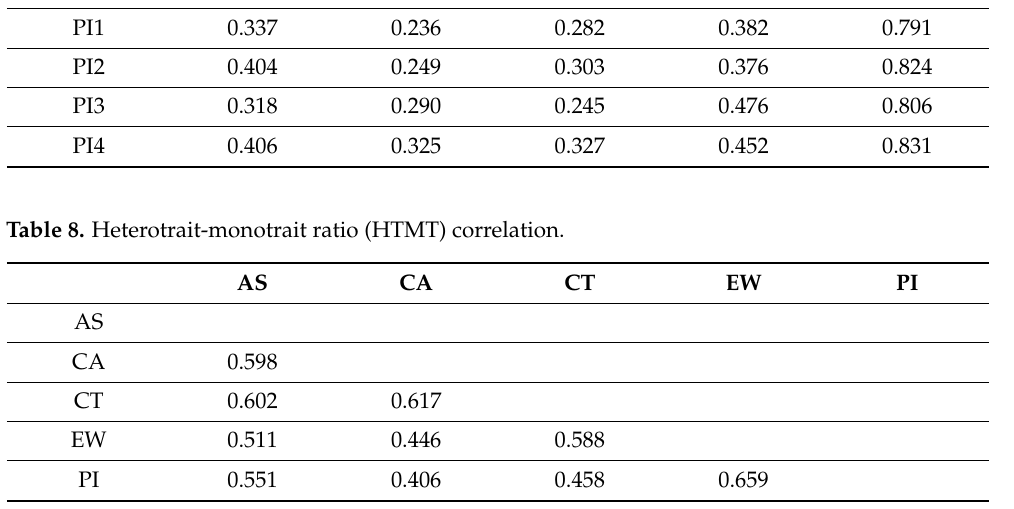
Figure 3. Path coefficient with p -values.